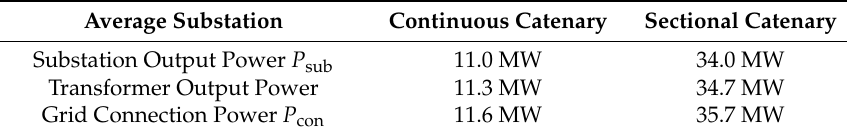
Table 4. Average substation components for the considered catenary